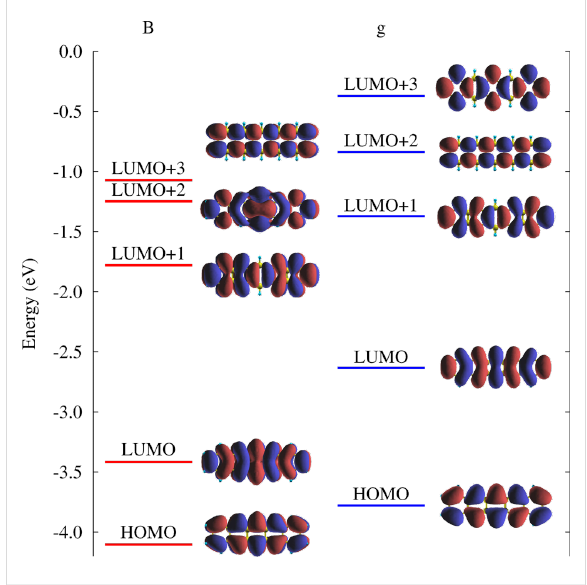
V-shaped gas phase pentacene with coordinates extracted from the bridge site adsorption (B) and the undistorted gas phase one (g). The corresponding orbital wave functions are also shown for each case.